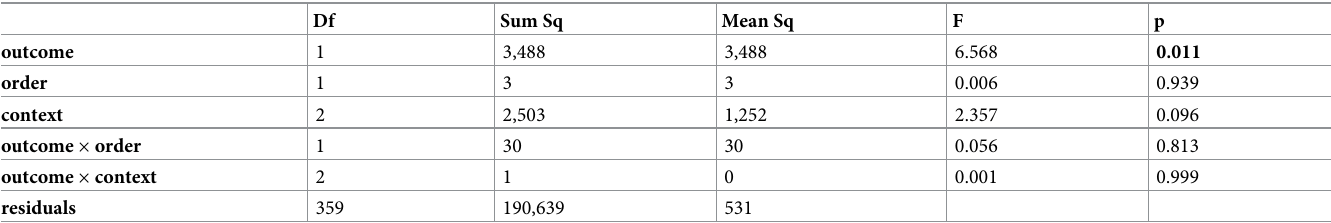
Table 4. Multi-way analysis of variance using immorality score as the